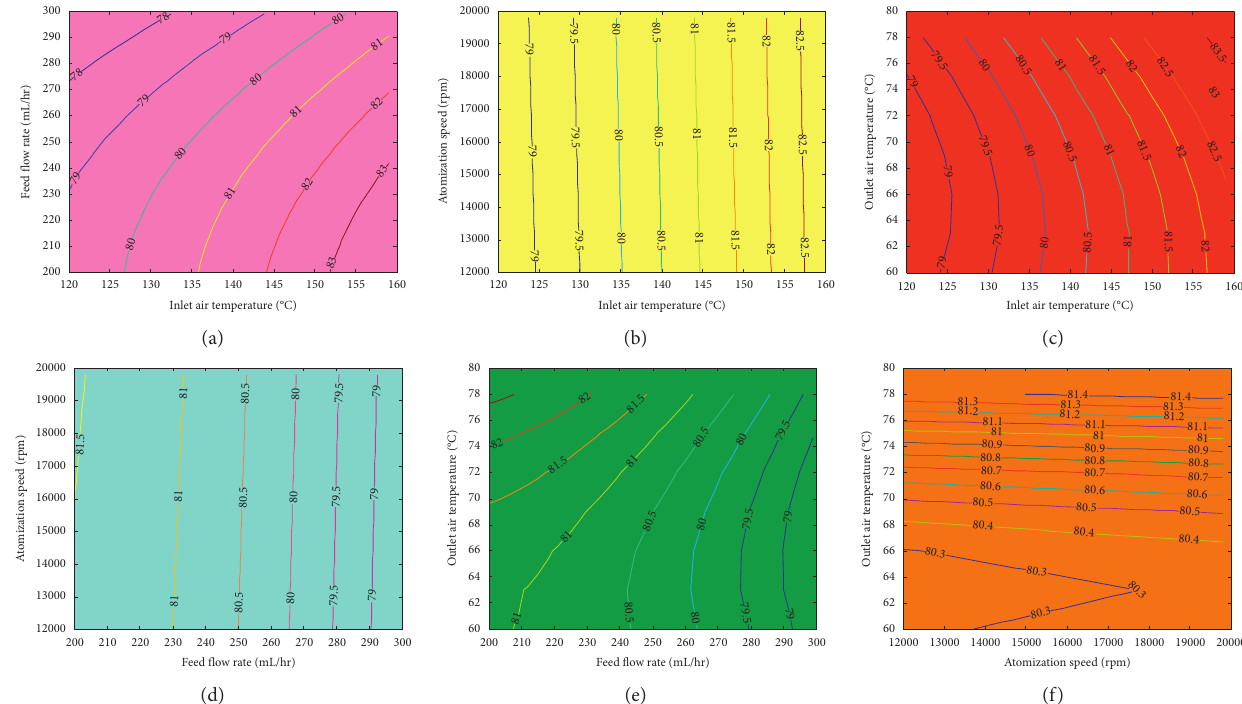
Figure 2: Contour plots for the mutual interaction effect of spray-drying conditions on the encapsulation efficiency of flaxseed oil